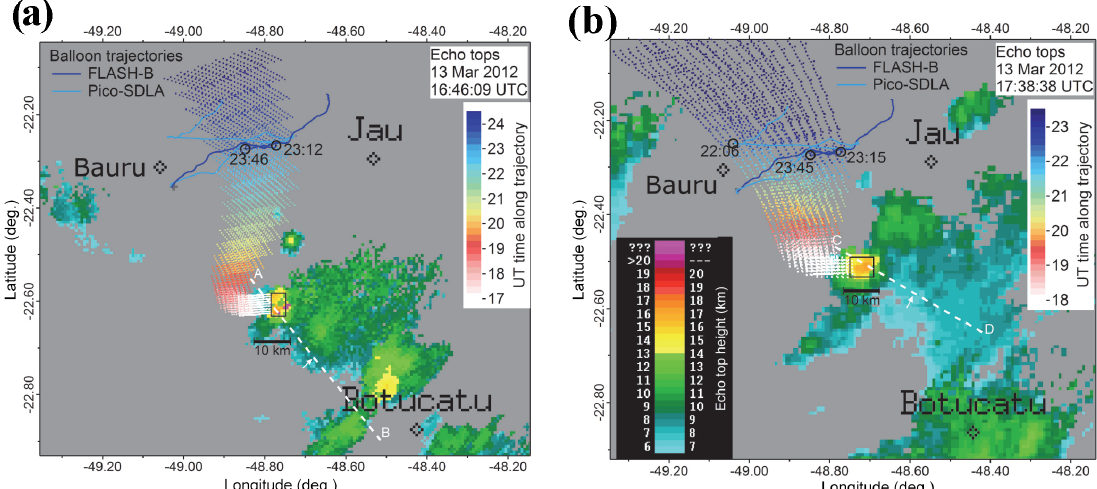
Figure 7. Echo top maps (reflectivity threshold 10dBZ) recorded by IPMet radar on 13 March. The overshooting cells, linked by trajectories with hydrated layers at 386 and 404K are outlined by rectangles in (a, b) . Solid lines indicate the trajectories of balloons carrying FLASH-B and Pico-SDLA hygrometers with indication of time (UTC) when 386 and 404K levels were sampled. Dots depict the ensembles of forward trajectories (colour-coded by UTC) initialised within the rectangle. Dashed white lines A–B in (a) and C–D (b) show the bases of vertical cross-section of the convective cells provided in Fig. 8.